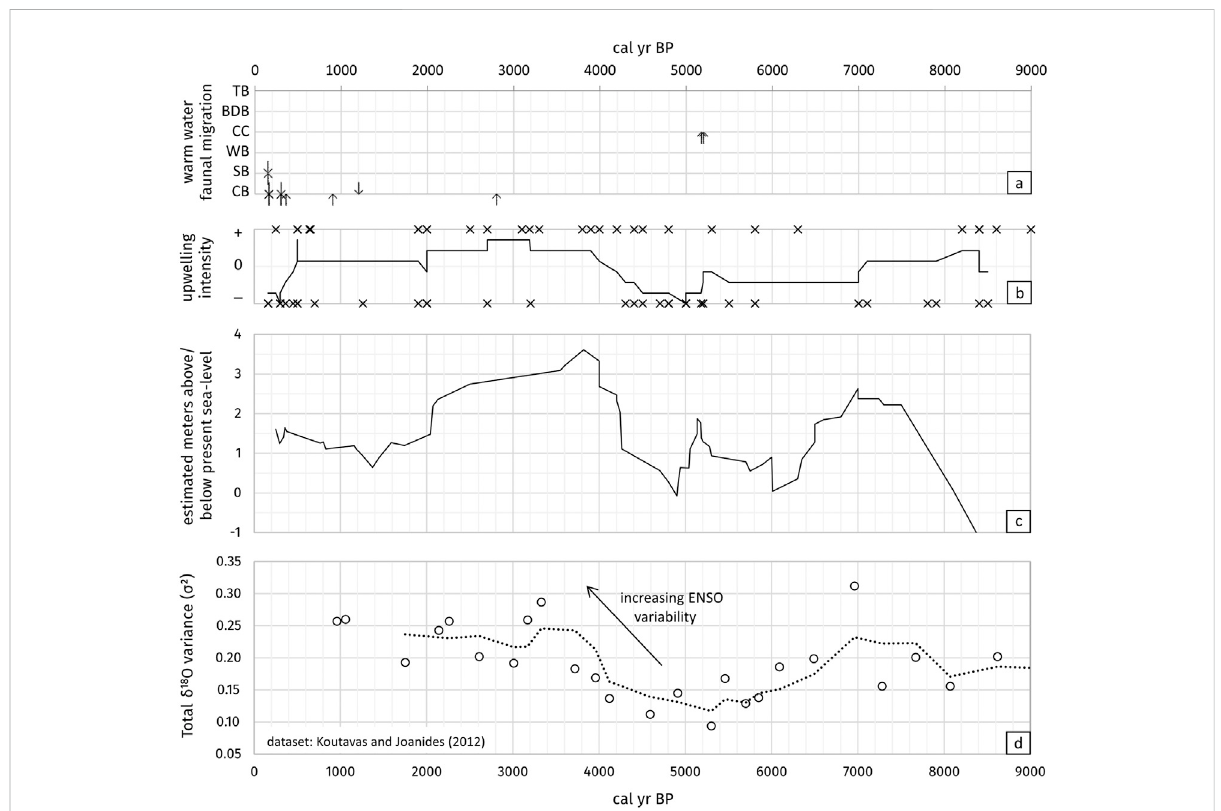
FIGURE 10 (A) Results of the biogeographic analyses of this study with age determination of the migratory fauna in the coastal lagoons (CB = Conception Bay, SB = Sandwich Bay, WB = Walvis Bay, CC = Cape Cross, BDB = Bandombay, TB = Torra Bay) and direction of movement (down arrows = extension from Angola Current, up arrows = extension from Agulhas Current). (B) Combined dataset from this study and other studies with information of the upwelling intensity during the last 9.0 ka BP (black crosses), “ + ” = stronger upwelling intensity than today, “ − ” = lower upwelling intensity until breakdown of the upwelling system. Solid line = fl oating mean over 7 values of all data (= approximate strength of the Benguela Upwelling system since 8.4 ka BP), for references see Supplementary Table S3. (C) Approximate Holocene sea-level curve since 9.0 ka BP (compare Figure 7, for references see Table 3). (D) Holocene ENSO variability from variance in δ 18 O in individual foraminifera ( Globigerinoides ruber ) records from the equatorial eastern Paci fi c (dataset: Koutavas and Joanides 2012), dashed line = fl oating mean over 3